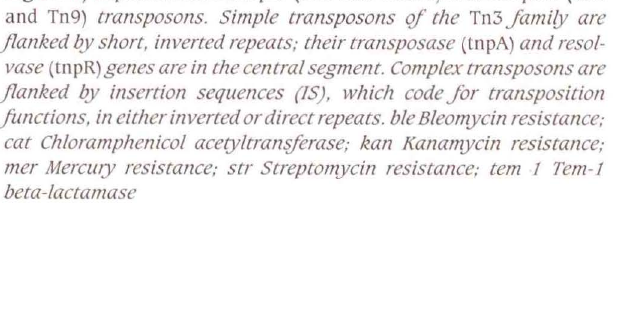
Figure 1) Representative simple (Tn3 and TnSOl) and complex